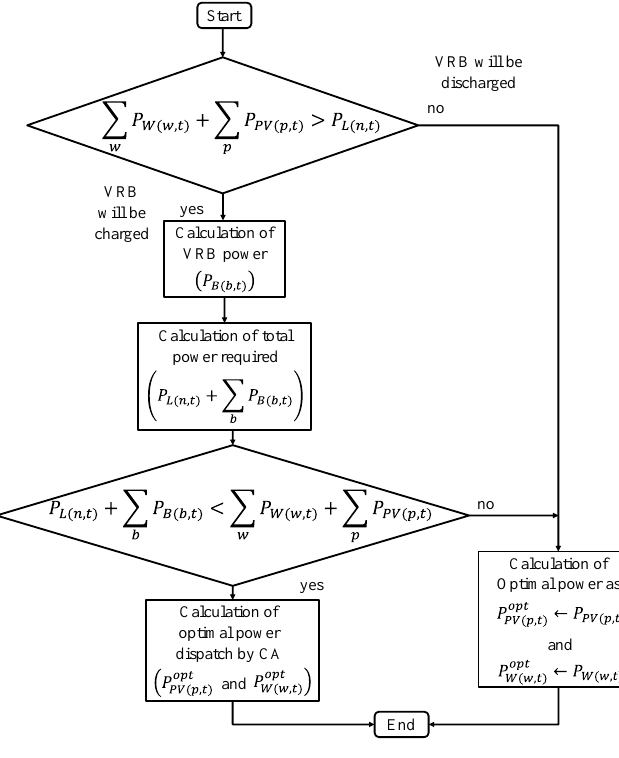
Figure 6. Flowchart of PV and wind power dispatch.